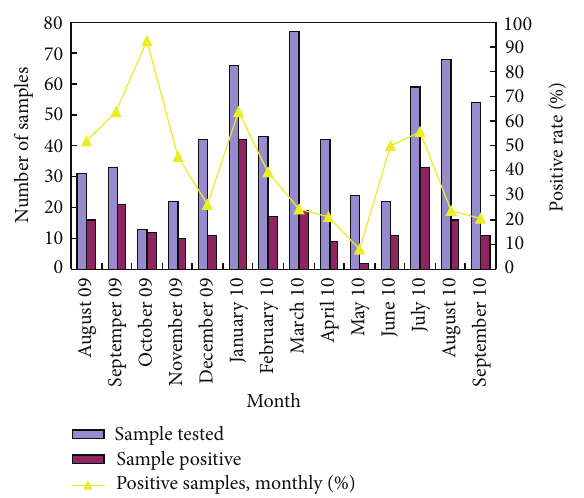
Figure 1: Number of tested and positive patients with ARTIs and the detection rate for each